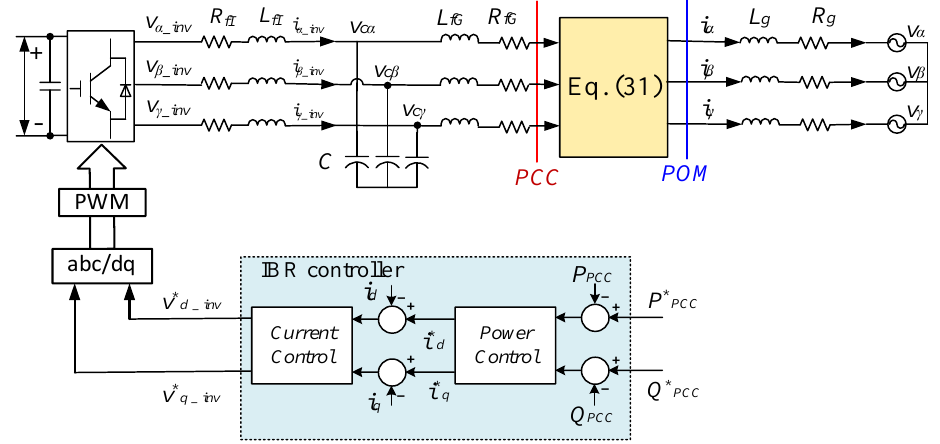
Figure 8. Aggregated IBR plant model for Case 1.